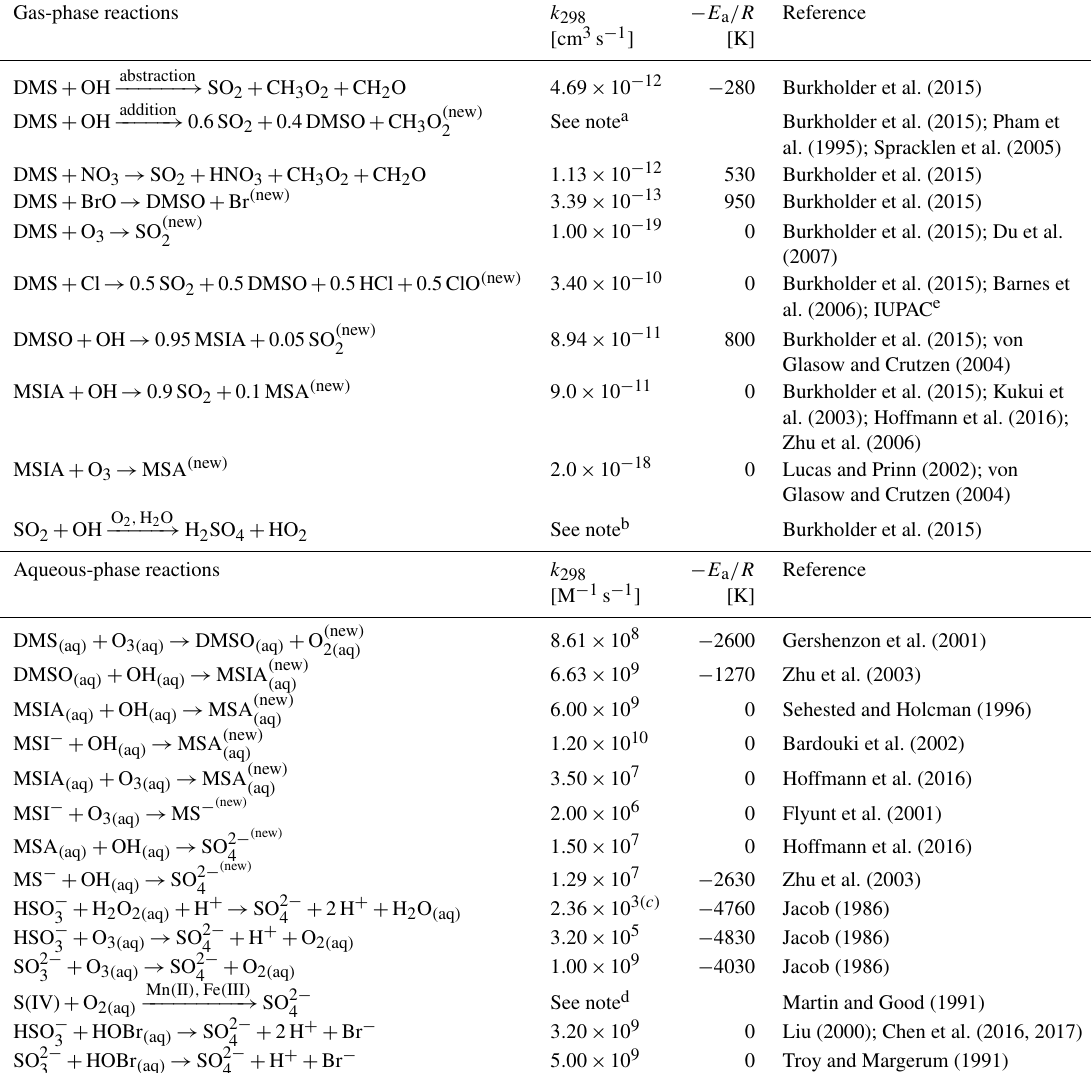
Table 1. Overview of sulfur chemistry in the full model run ( R all ) with DMSO and MSIA intermediates and all 12 new reactions. Gas-phase